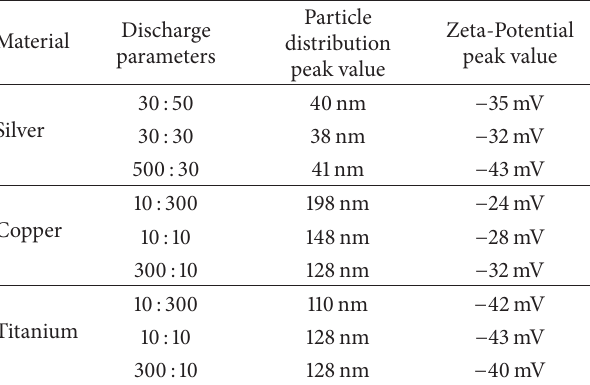
Table 4: Particle distribution peak value and Zeta-Potential peak value of metals in the case of different discharge